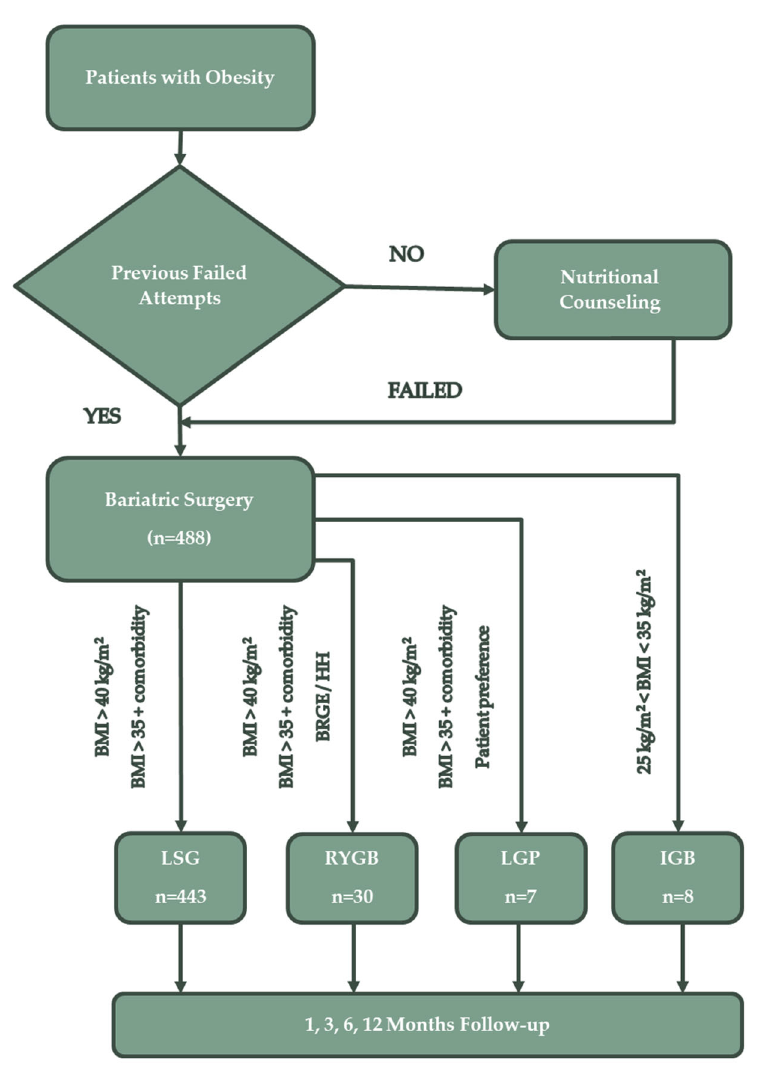
Figure 1. The selection and inclusion process for bariatric surgery candidates.